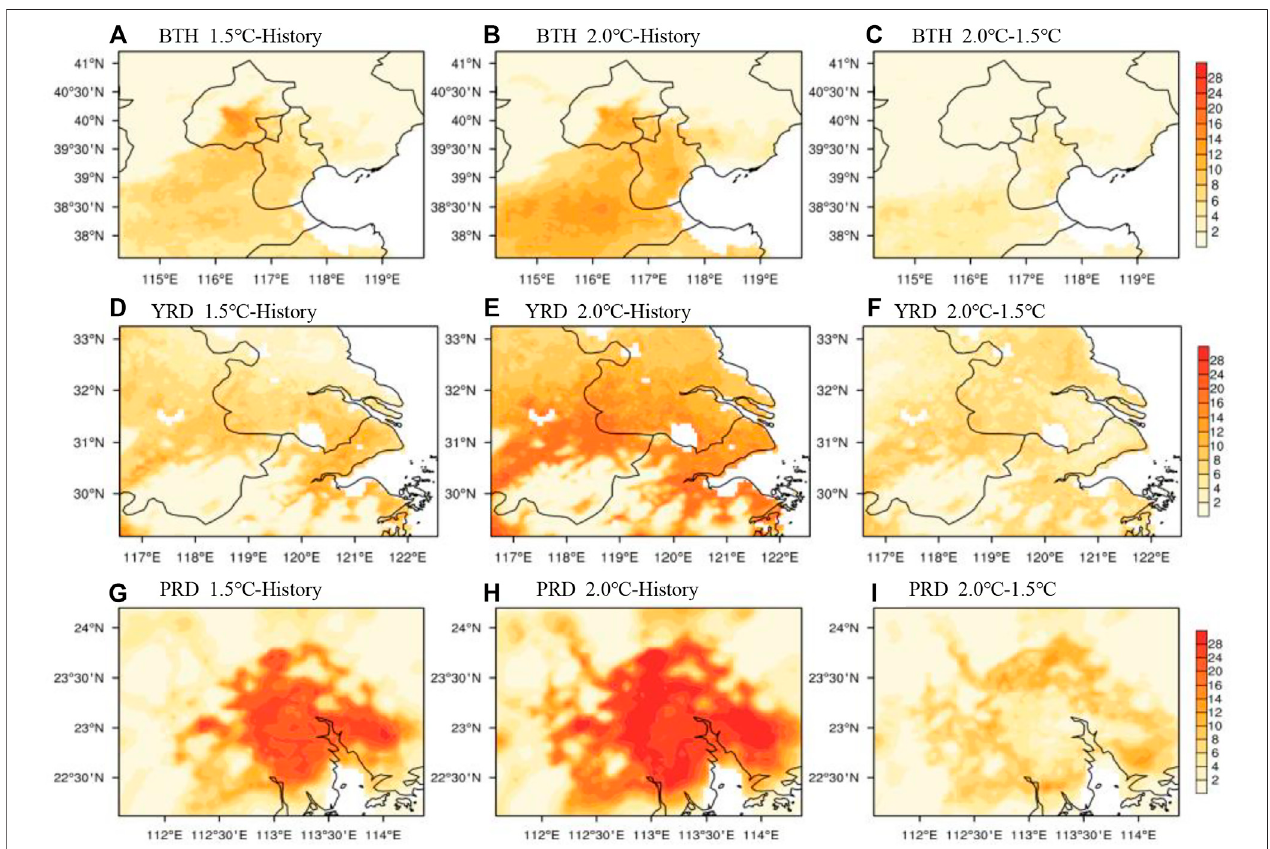
FIGURE7| SpatialdistributionsofthedifferenceinHWdurationoverthethreeurbanagglomerationsbetweenExp1.5-runandExpHIS-run (A,D,G) ,betweenExp 2.0-run and Exp HIS-run (B,E,H) , and between Exp 2.0-run and Exp 1.5-run (C,F,I) . The colored area indicates that the change is statistically signi fi cant at the 95% con fi dence